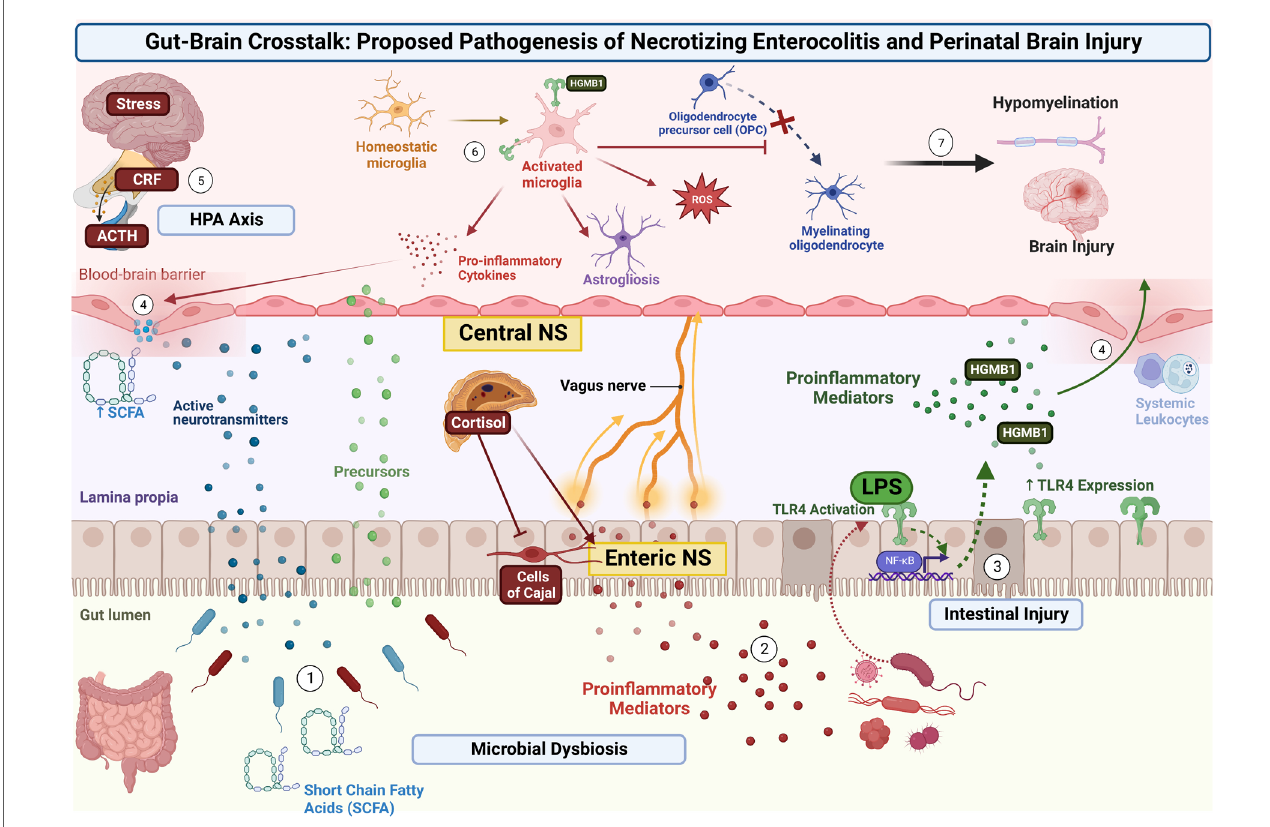
FIGURE 1 Proposed pathogenesis of NDI in NEC via the Gut-Brain Axis. Microbial dysbiosis and subsequent intestinal injury leads to the activation of several signaling pathways. (1) Pathogenic bacteria release signaling molecules including neurotransmitters, gasotransmitters, and short-chain fatty acids that cross the intestinal membrane and enter the systemic circulation. (2) Pathogenic bacteria release proin fl ammatory cytokines and other in fl ammatory mediators to stimulate the ENS within the intestinal wall, with signals traveling through the Vagus nerve, and ultimately to the CNS. (3) Intestinal injury and release of mediators (such as LPS) results in TLR-4 signaling and increased expression. This results in transcriptional changes via NF- κ B and further release of in fl ammatory mediators into the systemic circulation. (4) Systemic and neural in fl ammatory mediators weaken the BBB and allow further passage of pro- in fl ammatory mediators and systemic leukocytes. (5) Concurrently, stress is processed in the limbic system of the brain, resulting in release of CRF from the hypothalamus, release of ACTH from the pituitary, and the release of cortisol from the adrenal gland. This signaling through the HPA axis and increase in systemic cortisol results in further activation of the ENS and intestinal epithelial cells, while inhibiting interstitial cells of Cajal (resulting in decreased gut motility). (6) Signals and in fl ammatory mediators reach the CNS and cause local brain injury as well as activate microglia via ligands (such as HMGB-1) binding to TLR4. Activated microglia release pro-in fl ammatory cytokines and free radicals, stimulate astrocytes, and injure developing pre- oligodendrocytes. (7) The combination of these insults results in brain injury and